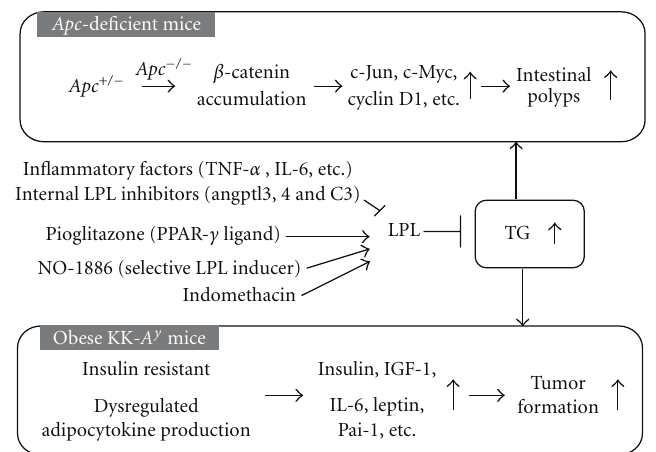
Figure 1: Involvement of triglycerides in animal intestinal carcinogenesis models. Angptl-3,4: angiopoietin-like protein-3,4; IGF-1: insulin like growth factor-1; IL-6: interleukine-6; LPL: lipoprotein lipase; Pai-1: plasminogen activator inhibitor-1; PPAR: peroxisome proliferator- activated receptor; TG: triglyceride; TNF- α : tumor necrosis factor-